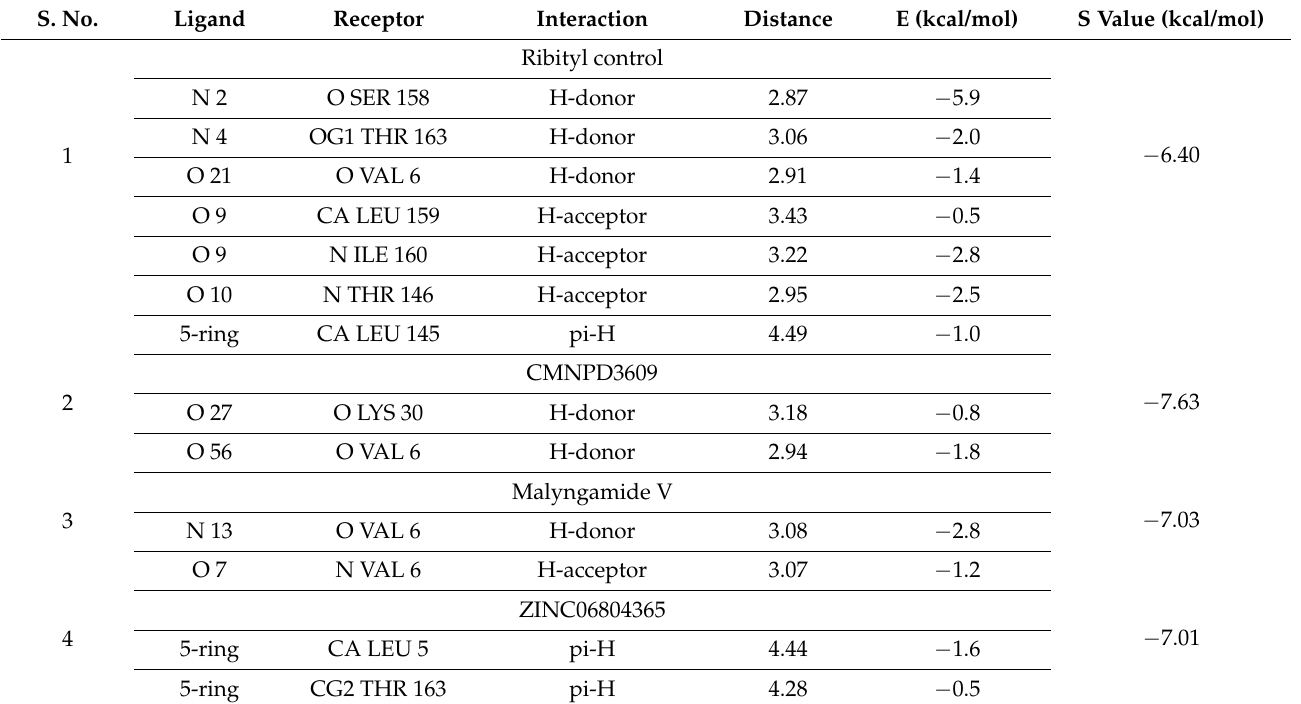
Table 2. Docking scores and identified bond types predicted through MOE tool for shortlisted compounds within the binding cavity of